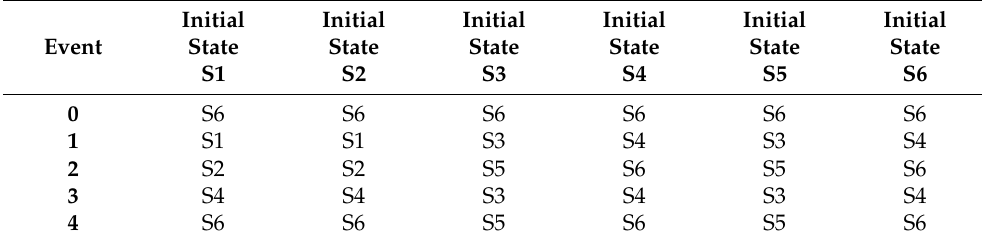
Table 10. Sub-part of the state transition matrix (splitter of the thermal control, initial control system).